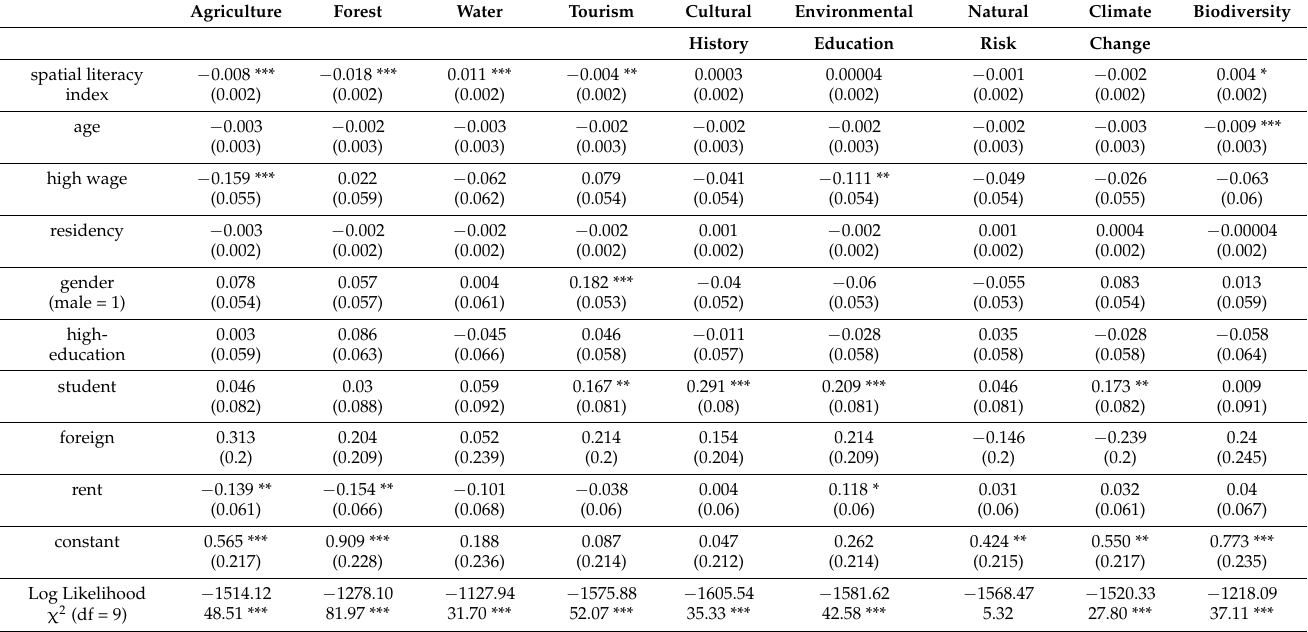
Table A4. Regression results for the first stage probit model of the two-stage model. These are the results that are reported in Table 5 of the main manuscript.